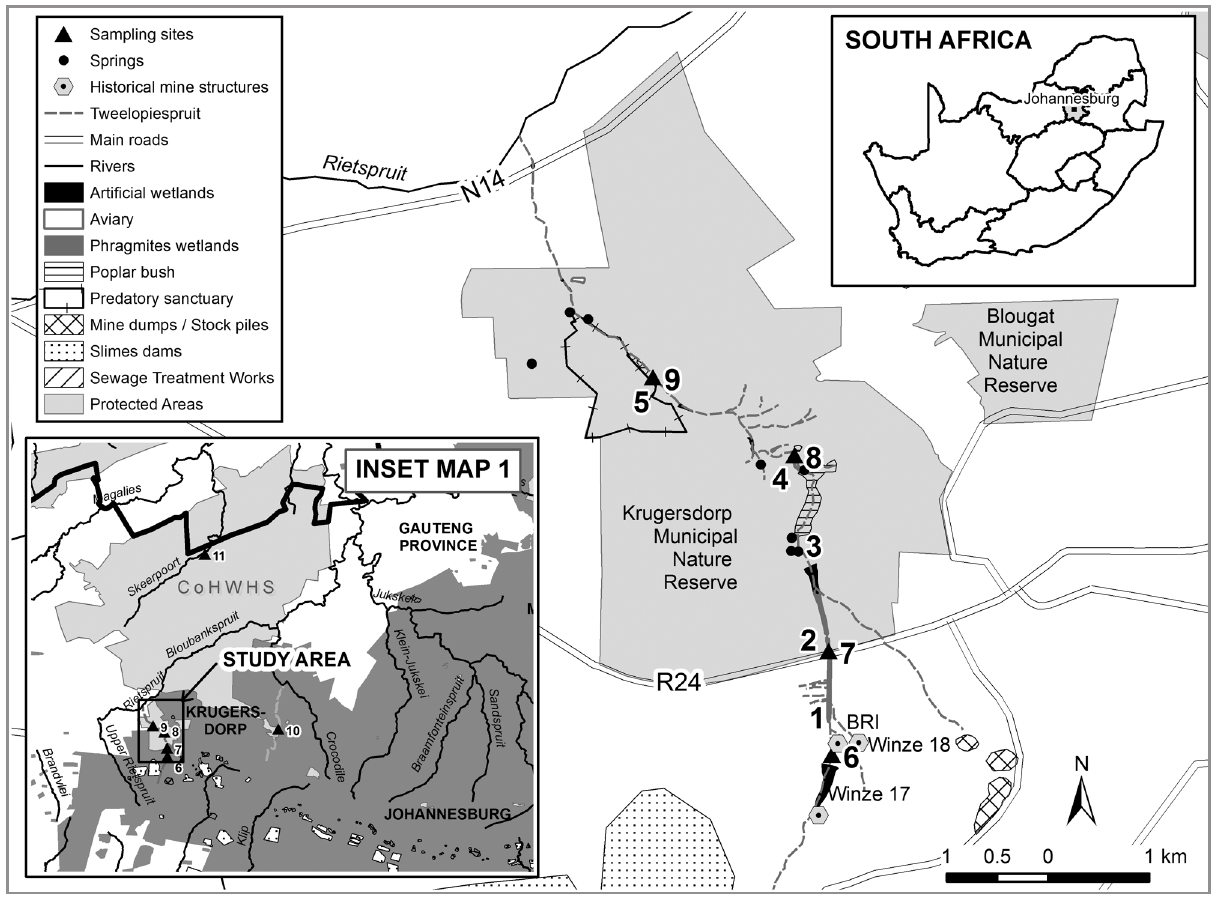
Figure 1: Inset map SOUTH AFRICA: Orientation map of Johannesburg in relation to South Africa. Inset map 1: The study area is located in the Gauteng Province to the west of Krugersdorp and Johannesburg. Mine dumps and slimes dams follow the watershed running from east to west, indicating historical and current mining operations on the Witwatersrand. Control Site 11 is located in the Skeerpoort River in the Cradle of Humankind World Heritage Sites (CoHWHS). Main map: The Tweelopiespruit drains from the mine property on the watershed northwards through a nature reserve to the confluence with the Rietspruit. Acid mine drainage was decanted at the Black Reef Incline (BRI) and at two ventilation shafts (Winze 17 and 18) in 2010 into the Tweelopiespruit. Dolomitic springs contribute fresh water to the surface stream. Sites 1 and 6 are located on the mine property and Sites 2–9 in the nature reserve along the stream where Phragmites australis occurs. Table 1: Sample sites along the affected Tweelopiespruit and two unaffected control sites Site numbers Location Treatment